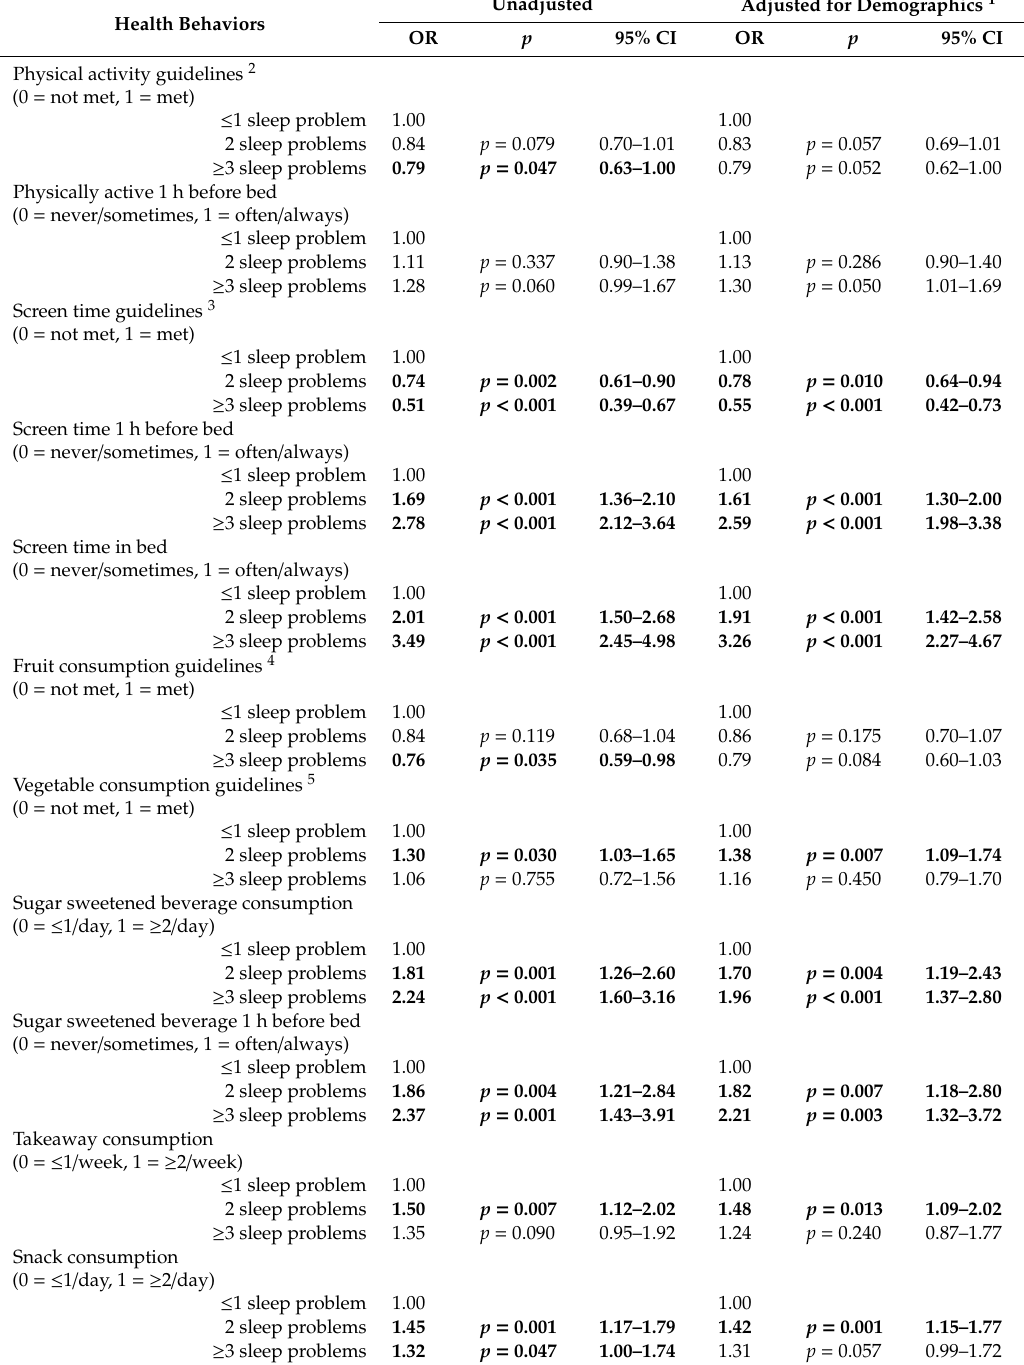
Table 3. Unadjusted and adjusted logistic regression with odds ratio (OR) of behavioral factors by sleep score # . Unadjusted Adjusted for Demographics 1 Health Behaviors OR p 95% CI OR p 95%